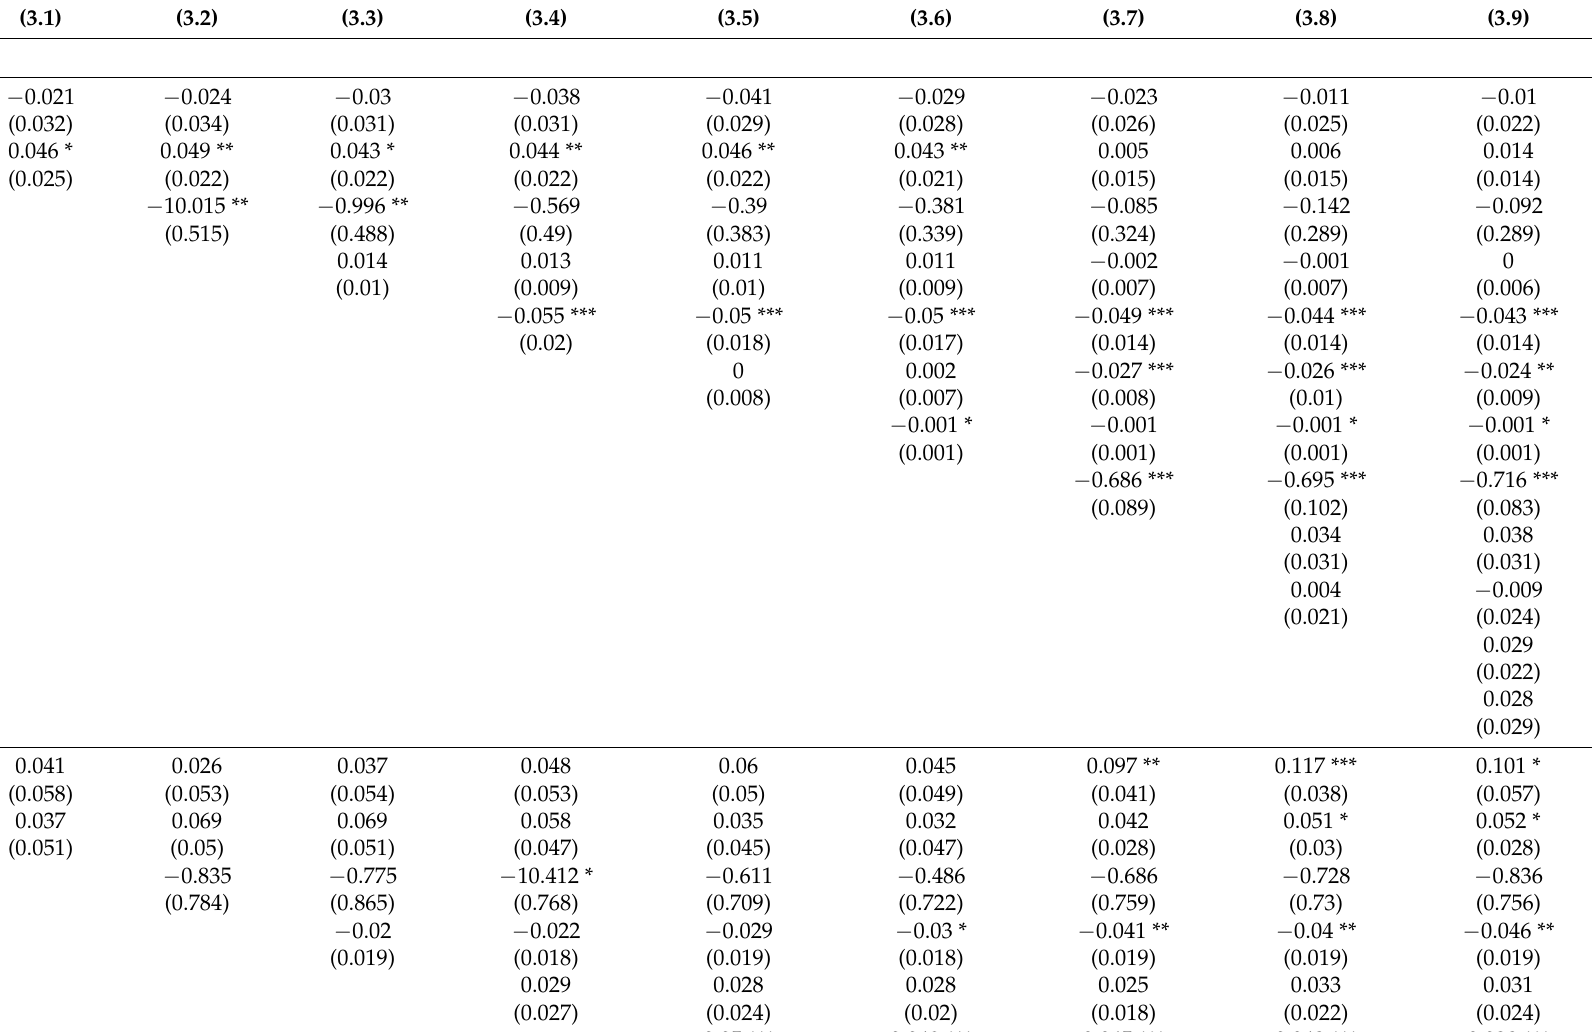
Table 3. Results of SDM using ML estimations (with earthquake and flood dummy